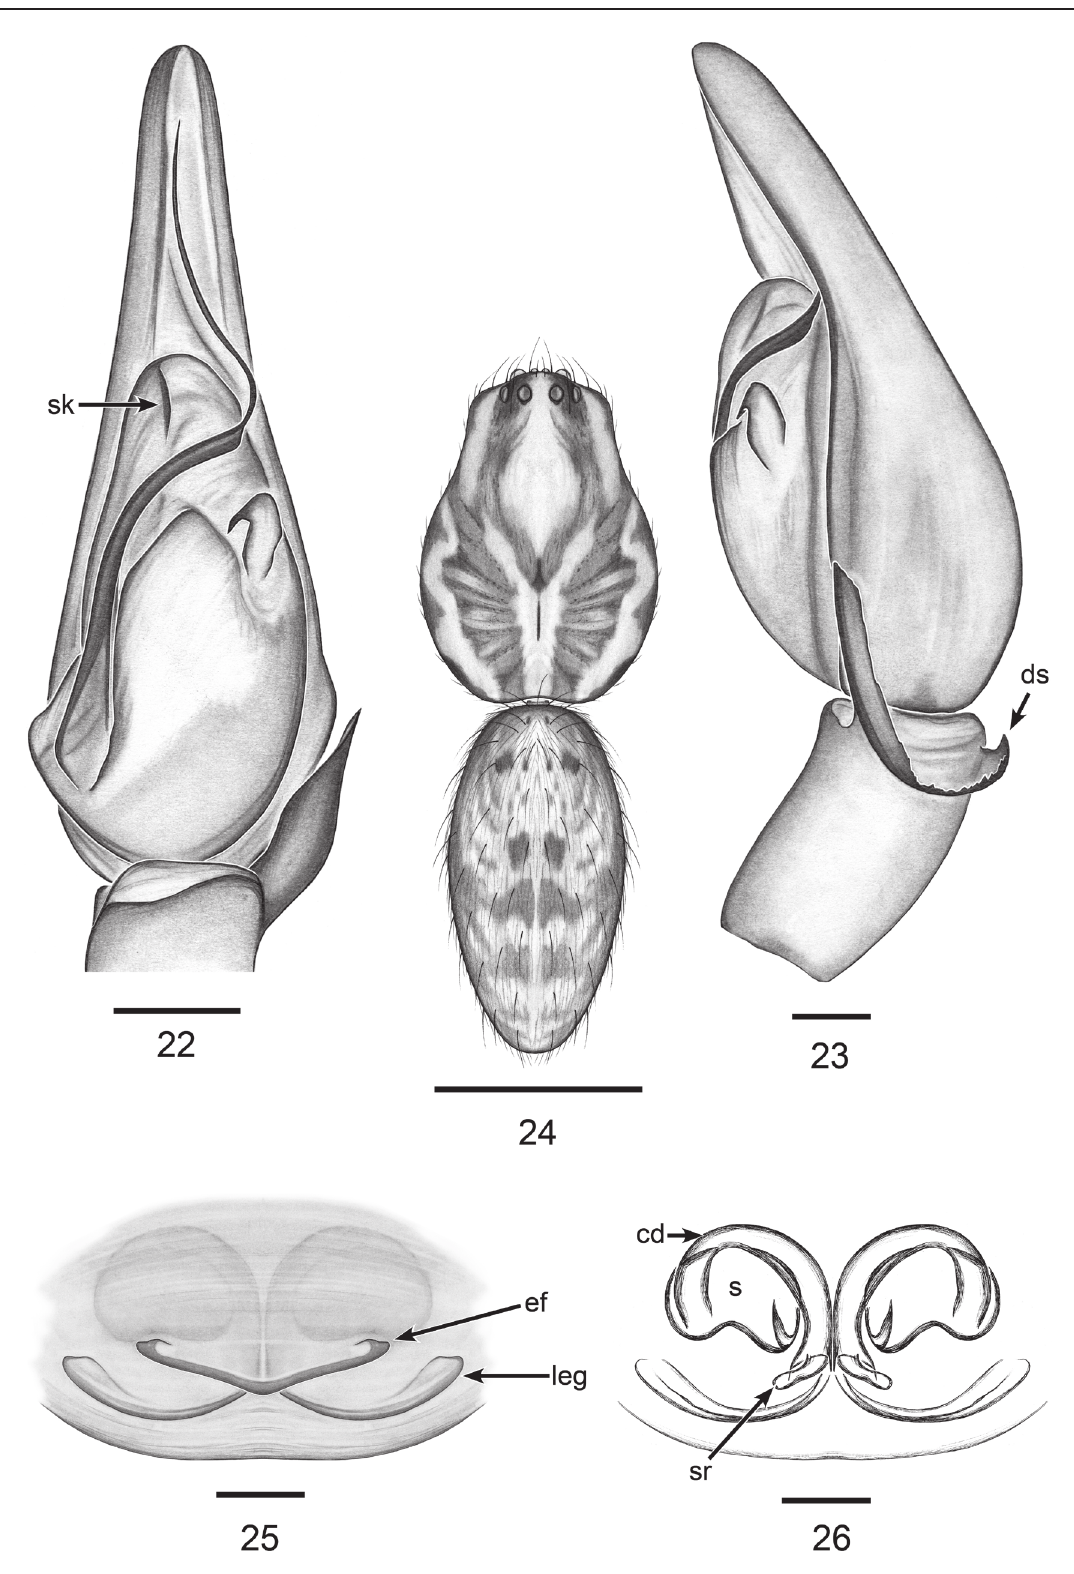
Figs 22–26. Katissa guayasamini sp. nov. 22 . ♂, palp, ventral view. 23 . ♂, palp, retrolateral view. 24 . ♂, habitus, dorsal view. 25 . ♀, epigynum, ventral view. 26 . ♀, internal genitalia, dorsal view. Scale bars: 22–23, 25–26 = 0.1 mm; 24 = 1